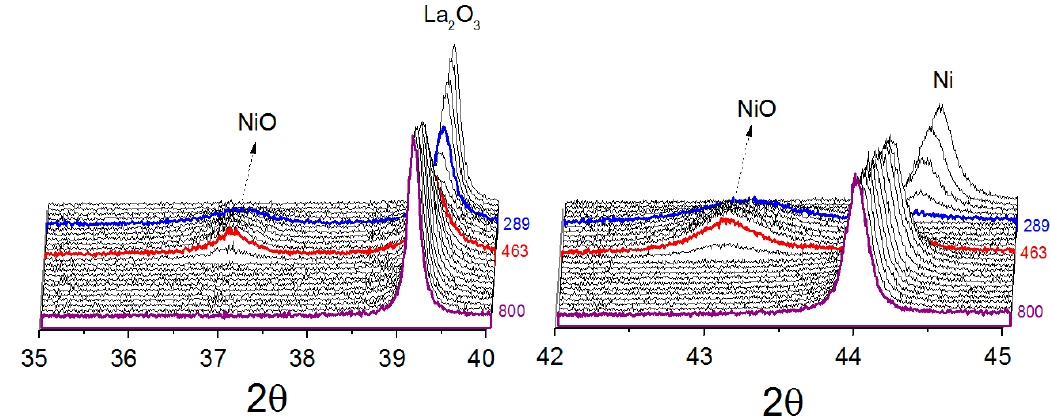
Figure 3. X-ray diffractograms for the catalysts under reaction atmosphere. LaNiO 3 .